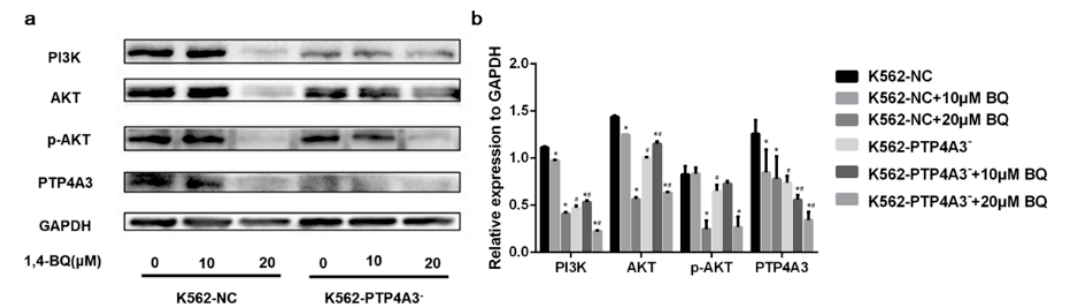
Figure 6. PI3K/AKT pathway was affected by PTP4A3 inhibition after 1,4-BQ exposure. ( a, b ) The expression of PTP4A3 and key proteins in PI3K / AKT pathway after 1,4-BQ treatment. GAPDH was expression of PTP4A3 and key proteins in PI3K/AKT pathway after 1,4-BQ treatment. GAPDH was applied to internal reference. *: p < 0.05, compared with 0 µ M group; #: p < 0.05, compared with applied to internal reference. *: p < 0.05, compared with 0 μ M group; #: p < 0.05, compared with K562-NC cells at the same concentration of K562-NC cells at the same concentration of 1,4-BQ.